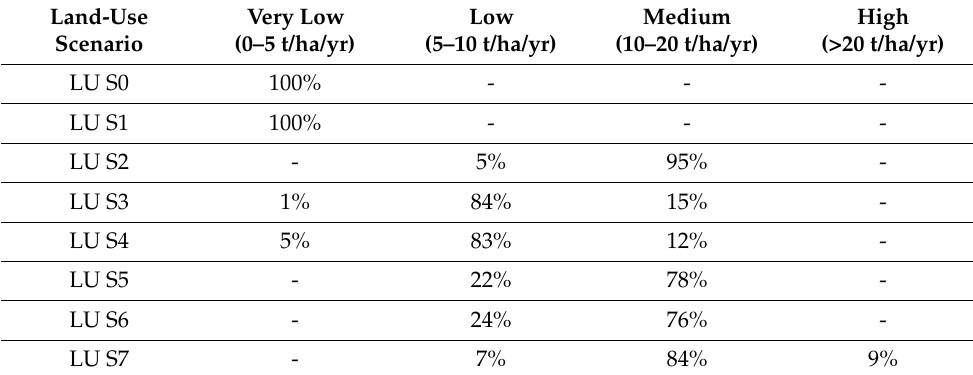
Table A2. Land area under different soil erosion severity